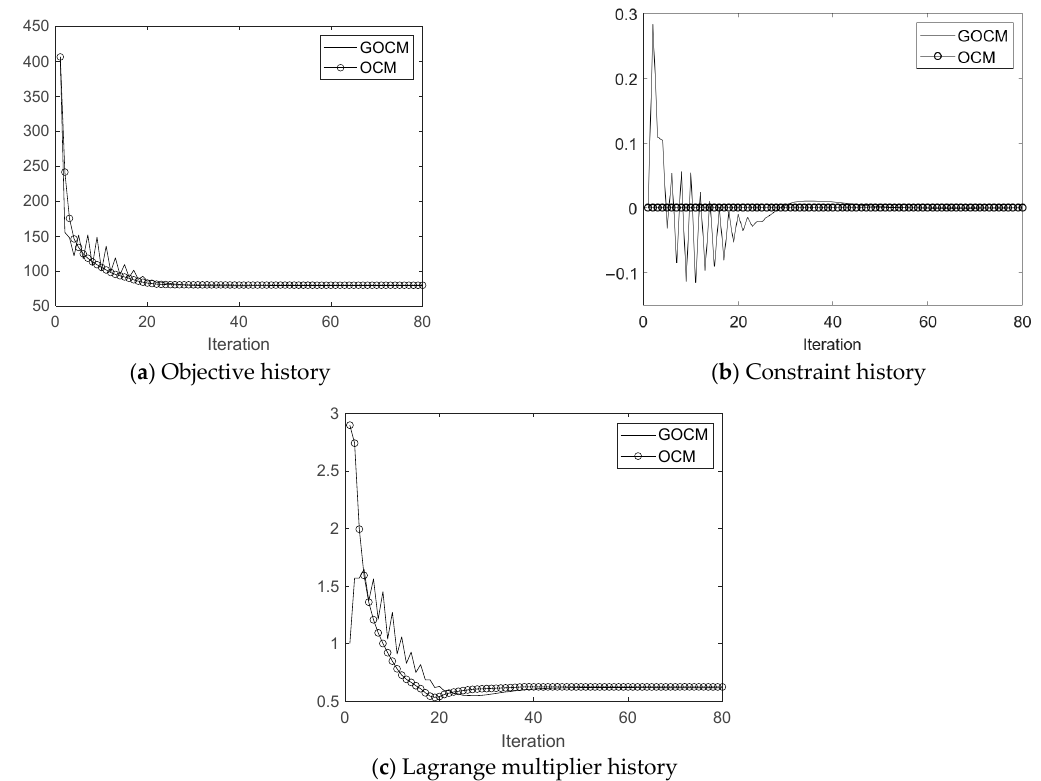
Figure 3. Design optimization histories for optimality criteria method (OCM) and generalized optimality criteria method (GOCM).